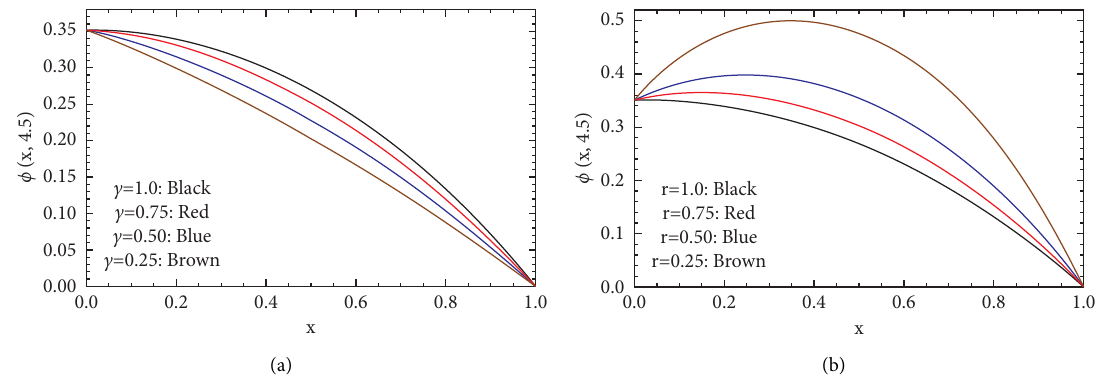
Figure 4: The approximate solution at F � 6and T